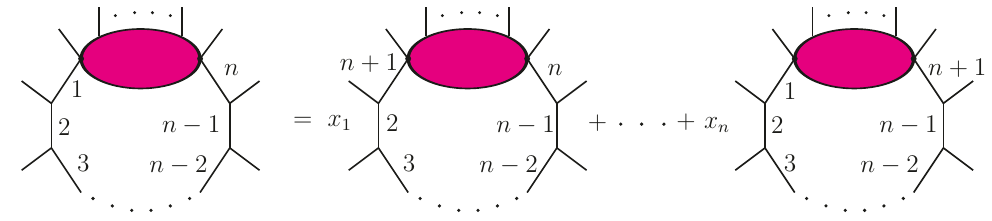
Figure 2 . n -propagator functional